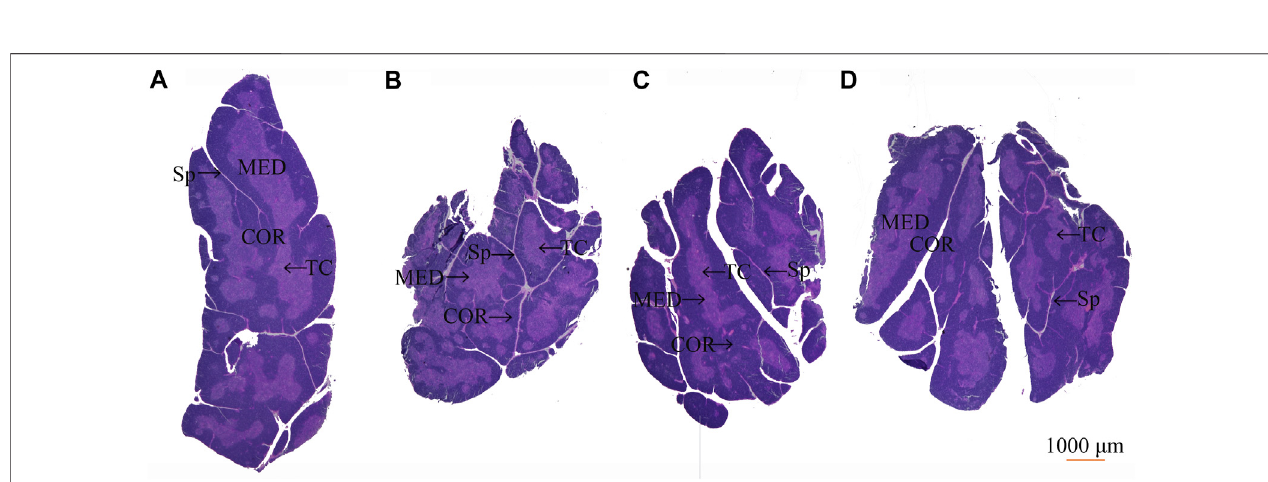
FIGURE 8 | The effect of PDS and PTS on thymus histopathology in myelosuppression mice. (A) control group; (B) model group; (C) PDS group; (D) PTS group. (COR-cortex, MED-medulla, TC- thymic corpuscle, Sp-septum).